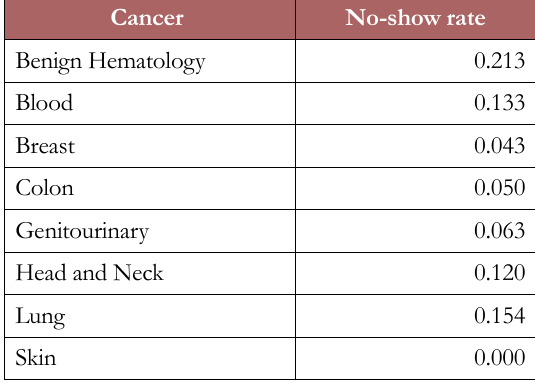
Table 1. New patient no-show